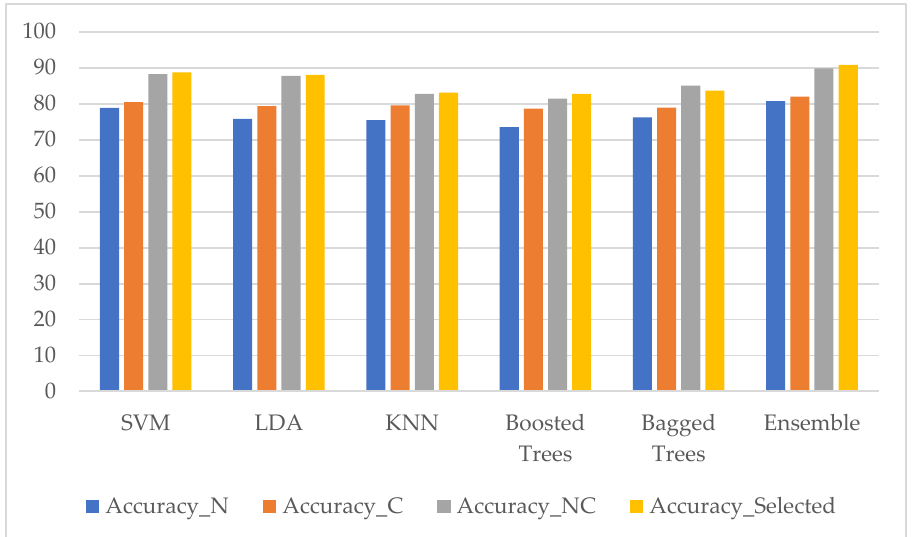
Figure 19. Classification performance of five classifiers and our ensemble classifier in terms of accuracy using four datasets (nuclei features only (Accuracy_N), cytoplasm features only (Accuracy_C), combining nuclei and cytoplasm features without features selection method (Accuracy_NC), and with features selection method (Accuracy_Selected)). (Herlev dataset for the seven-class problem).